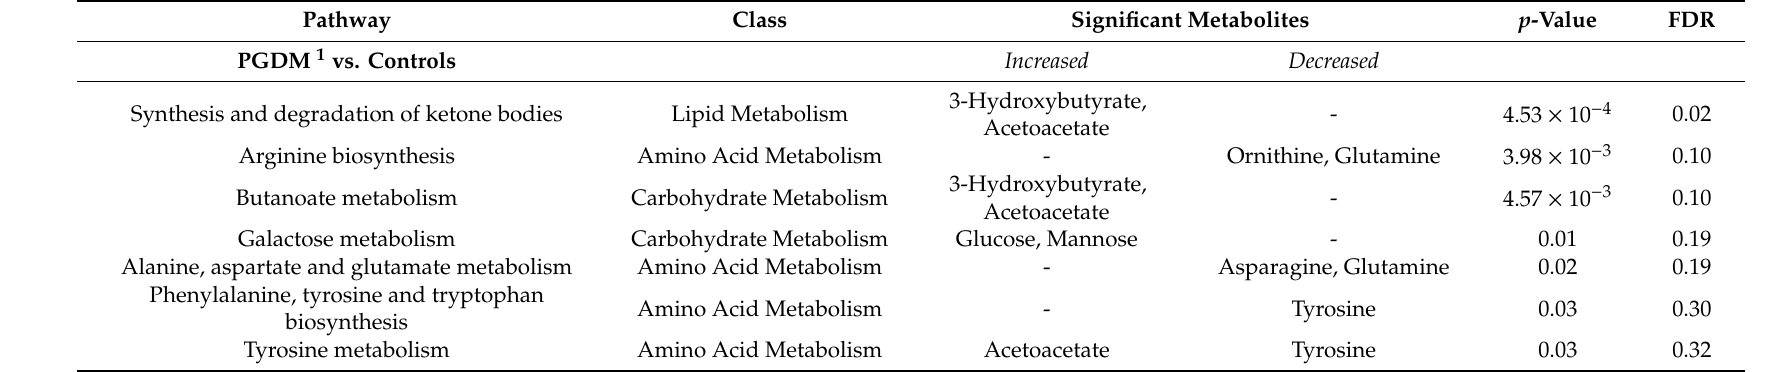
Table 6. Pathways Significantly Altered in Maternal Serum in PGDM during the Immediate Post-Partum